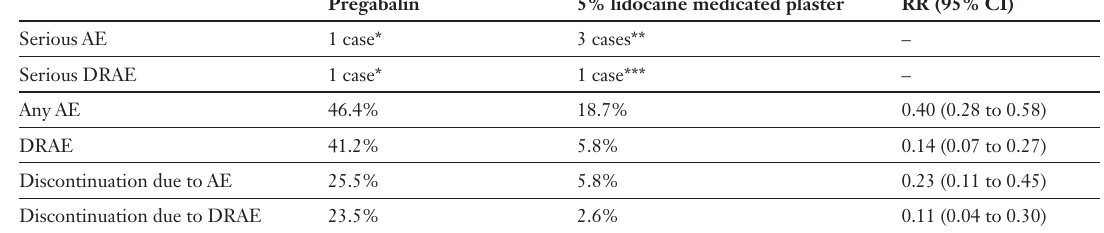
Adverse events in the pregabalin and 5% lidocaine medicated plaster groups.